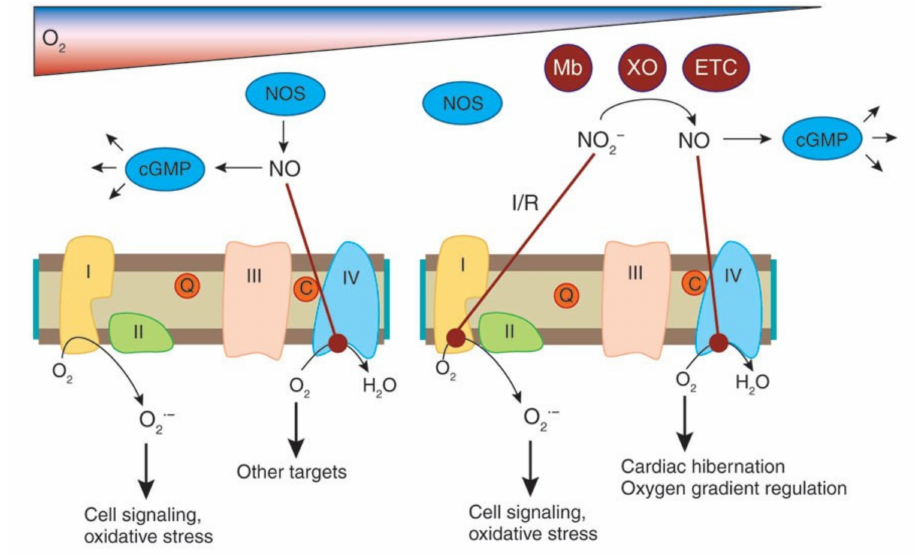
Figure 4. Molecular targets and biological effects of Nitric Oxide. Source: Lundberg et al., The nitrate-nitrite-nitric oxide pathway in physiology and therapeutics. Image reproduced with author’s and Nature publishing group’s